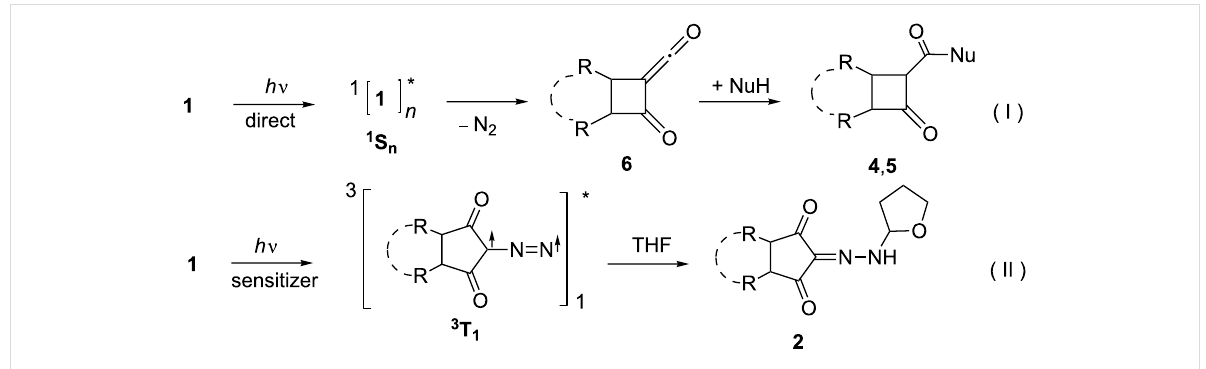
Scheme 2: Different pathways of diazodiketones 1 light-induced reactions in the singlet (reaction I) and triplet (reaction II) excited